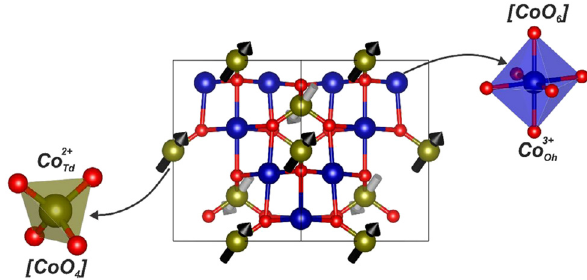
Figure 9: Cubic structure of Co 3 O 4 , showing cobalt ions Co 2 + and Co 3 + that shows tetrahedral and octahedral coordinates with oxygen ions, respectively [ 80 ] .